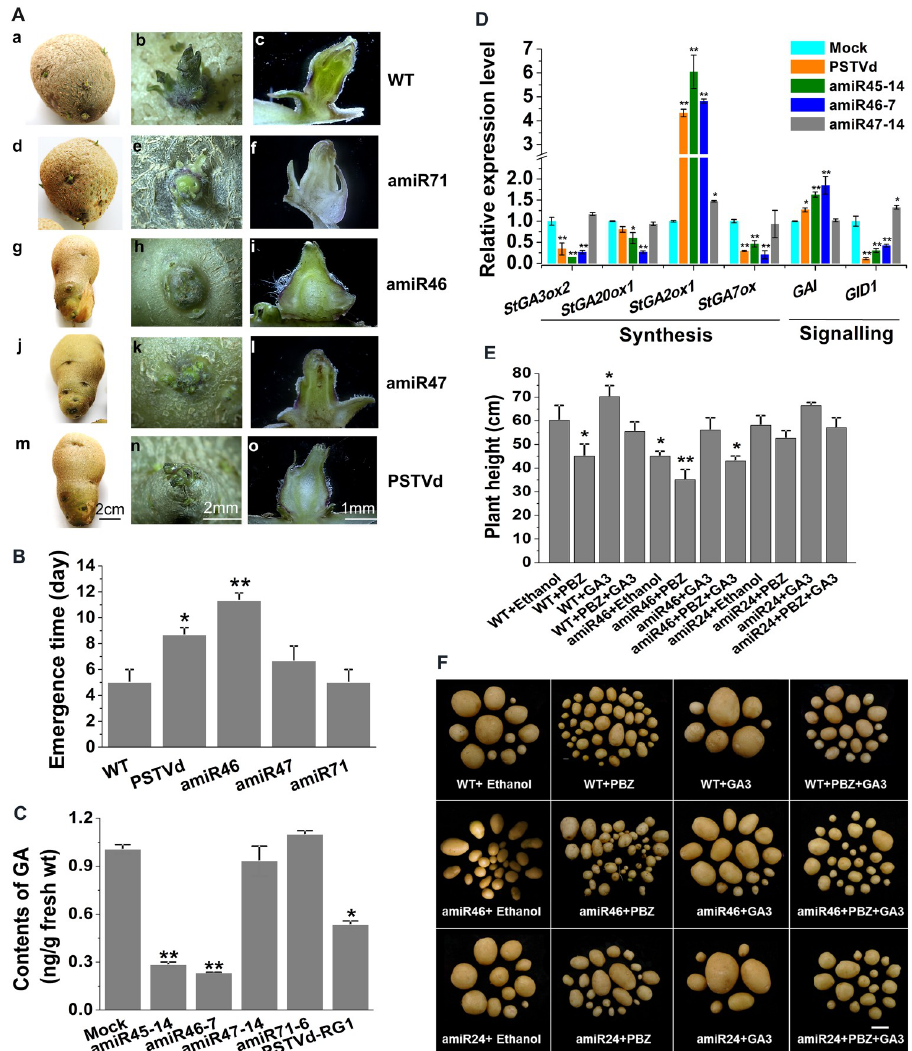
Fig 7. Regulation of the GA pathway by amiRNA46 and St TCP23. (A) Sprouting behavior of tuber discs prepared from amiRNA transgenic and control potato lines. (a, b, c), mock inoculated plants; (d, e, f), transgenic plants expressing amiR71; (g, h, i), transgenic plants expressing amiR46; (j, k, l), transgenic plants expressing amiR47; (m, n, o), PSTVd inoculated non-transgenic plants. (a, d, g, j, m), sprouting behavior of whole tubers, scale bar = 2 cm; (b, e, h, k, n), sprouting behavior of individual buds, scale bar = 2 mm; and (c, f, i, l, o), cross sections of individual sprouting buds under the scanning electron microscope, scale bar = 1 mm. (B) Delayed emergence of new stems in transgenic plants expressing amiR46, amiR47 and PSTVd-inoculated non-transgenic plants as compared with transgenic plants expressing amiR71 and uninoculated non- transgenic control plants. (C) Comparison of endogenous GA 3 levels in uninfected control, amiR45, amiR46, amiR47, amiR71, and PSTVd-infected non- transgenic plants. (D) RT-qPCR quantitation of selected genes involved in gibberellin metabolism. Total RNA was extracted from tuber harvested at bulking stage during potato tuber development. (E) Comparison of plant height for the different treatments. (F) Morphology of tubers collected from non-transgenic and amiR46, amiR24 transgenic plants after treatment with ethanol, PBZ, or GA 3 . Scale bars = 3